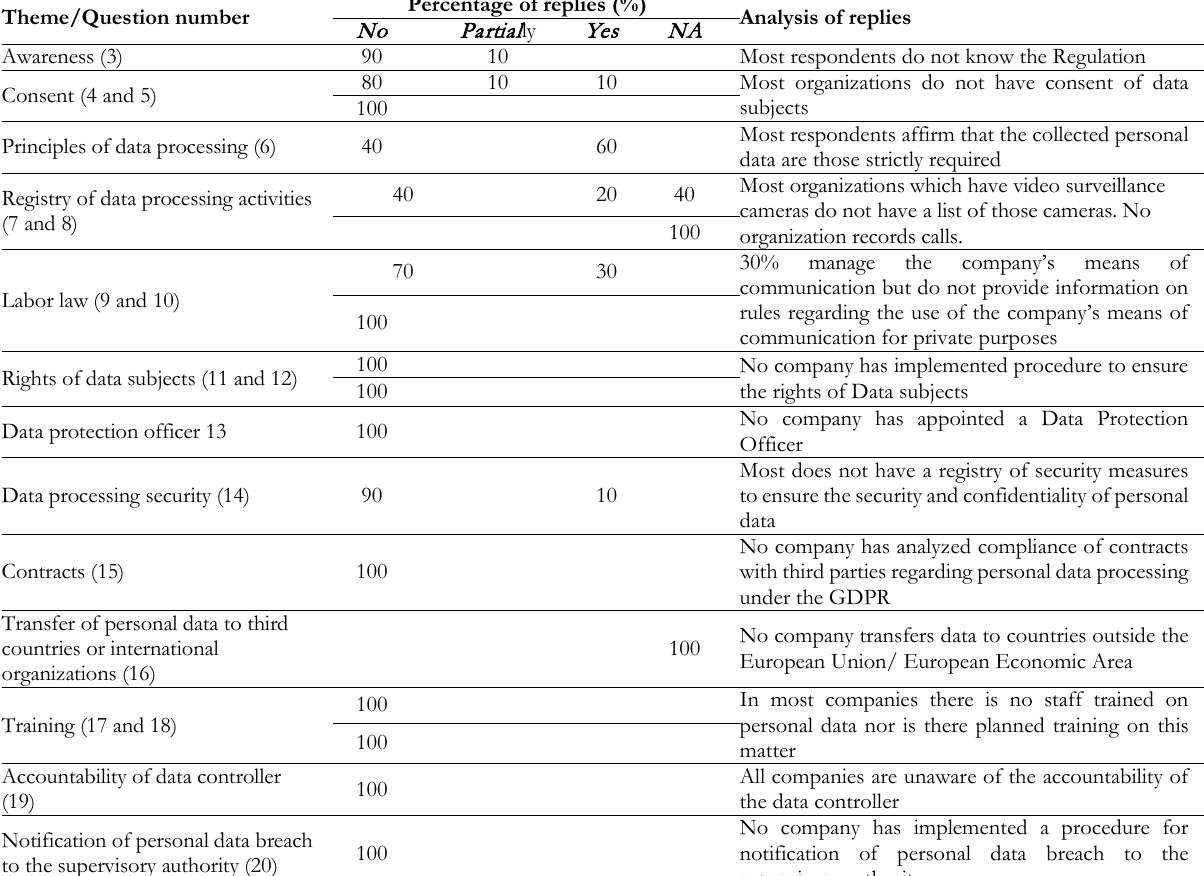
Table 2. Summary of